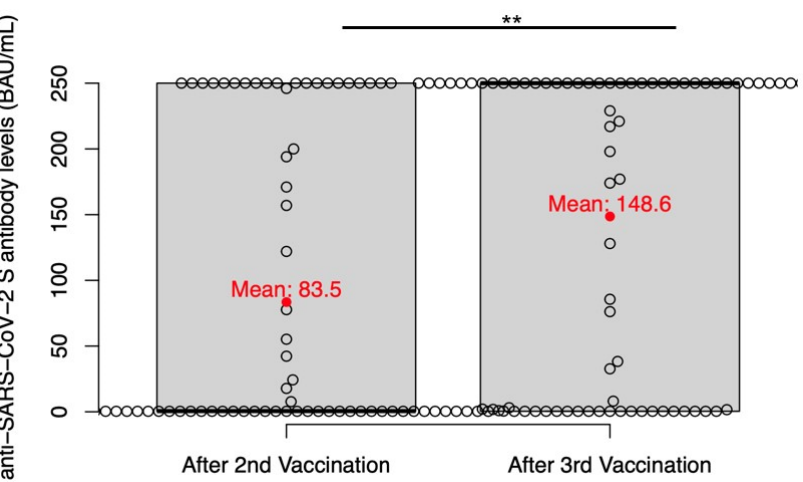
Figure 1. Comparison of anti-SARS-CoV-2 antibody levels after the 2nd and 3rd vaccination. The dots illustrate the antibody titer levels of individual cases. The median values are displayed with